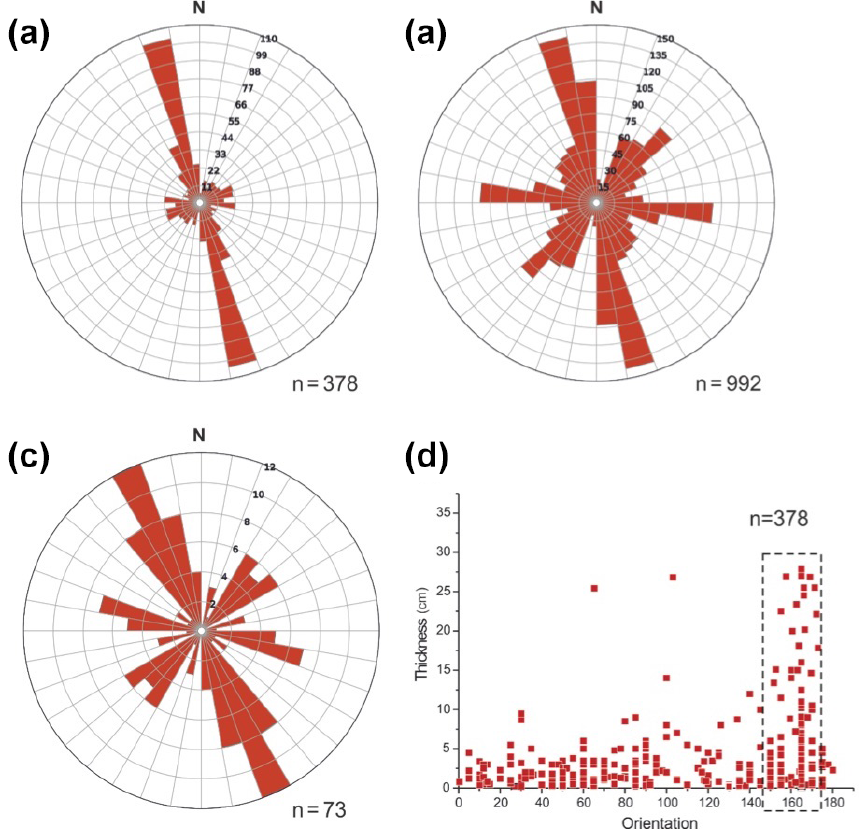
Figure 4. Rose diagrams and graphs of structural data recorded from the study area. (a–c) are the rose diagrams of the strike orientation of the quartz veins, fractures and fault planes, respectively. Note that the veins are mostly NNW–SSE striking, whereas the fractures and fault planes show variable orientations, with a NNW–SSE maximum and a WNW–ESE to NE–SW sub-maximum. (d) Graph of vein orientation vs. thickness, showing maximum vein thickness along NNW–SSE (marked with a black box). n : number of